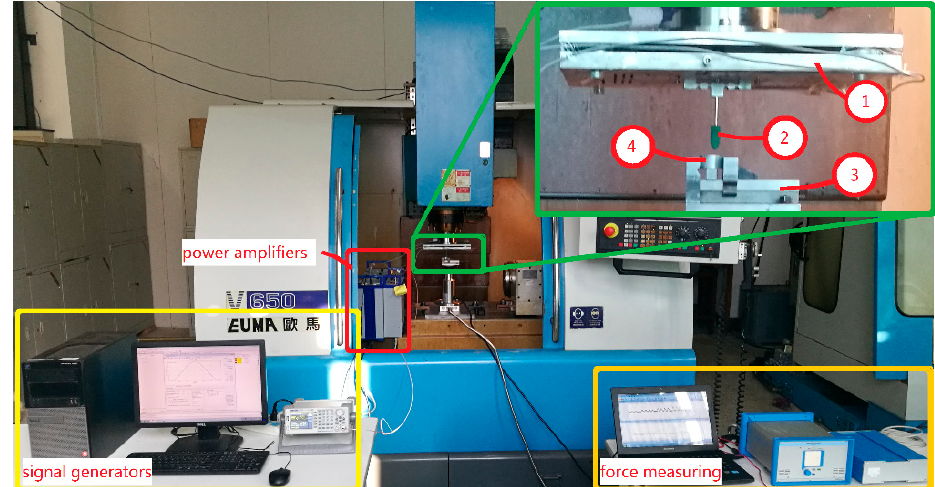
Figure 39. 3D vibration scratching experiment system ( 1 ) flexible mechanism device; ( 2 ) experimental tool; ( 3 ) workpiece holder; ( 4 ) workpiece.